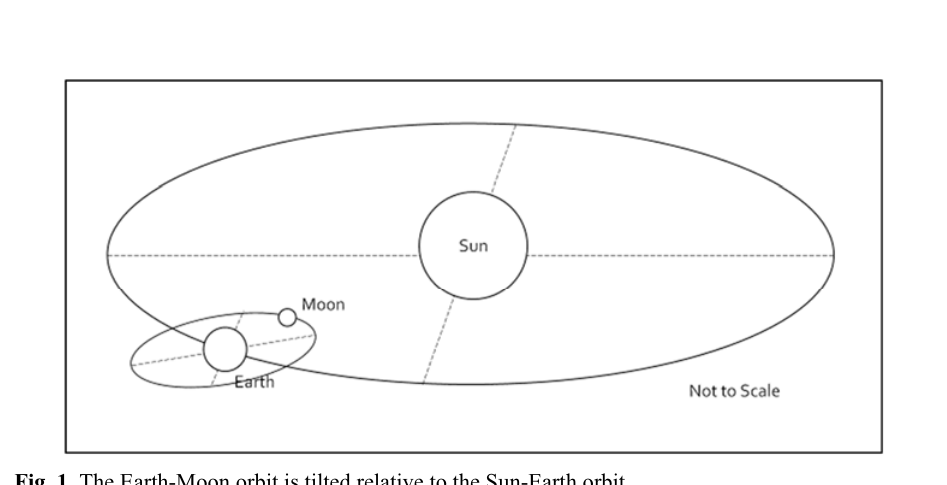
Fig. 1. The Earth-Moon orbit is tilted relative to the Sun-Earth orbit